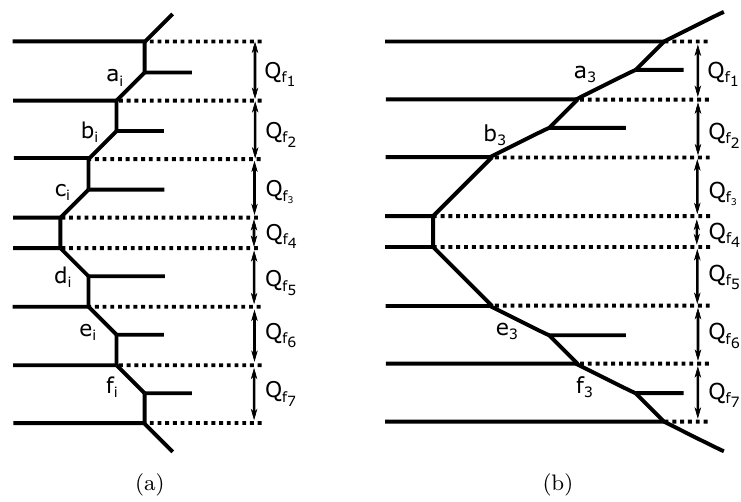
Figure 47. (a). Local geometry near the SU(8) part of the two long quiver tails of the affine E 7 Dynkin quiver theoriy (2.65). i labels the two long quiver tails and i = 1 , 2 . (b). Local geometry near the SU(8) part of the short quiver tail of the affine E 7 Dynkin quiver theory (2.65).